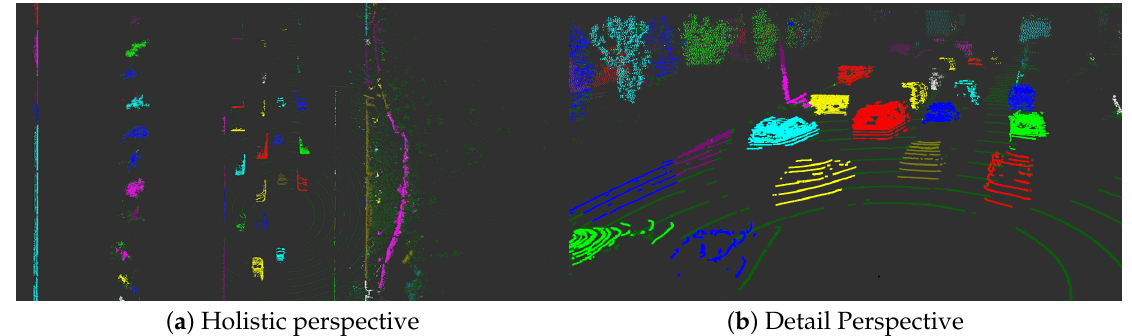
Figure 10. Different objects are represented by different colors, and different traffic objects on the road are well distinguished, although the trees outside the road are also well distinguished (LiDAR is Robosense RS-Ruby (128